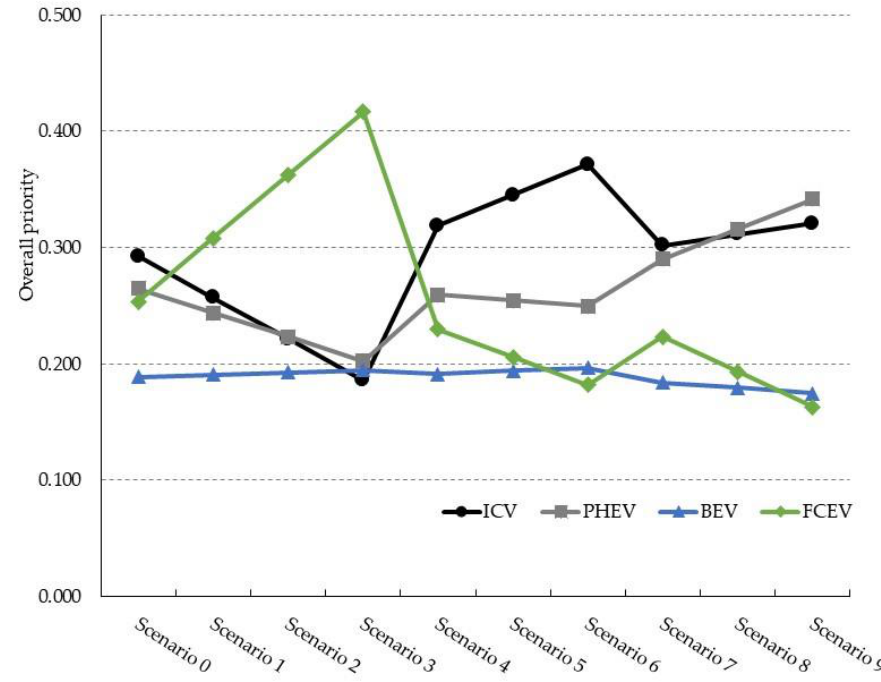
Figure 2. Overall priority of the alternatives for the ten scenarios.